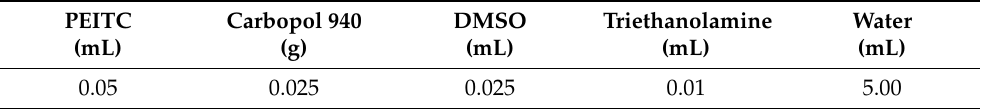
Figure 1. Photographic image of the blank carbomer (left) and phenethyl isothiocyanate (PEITC) carbomer (right) gels.